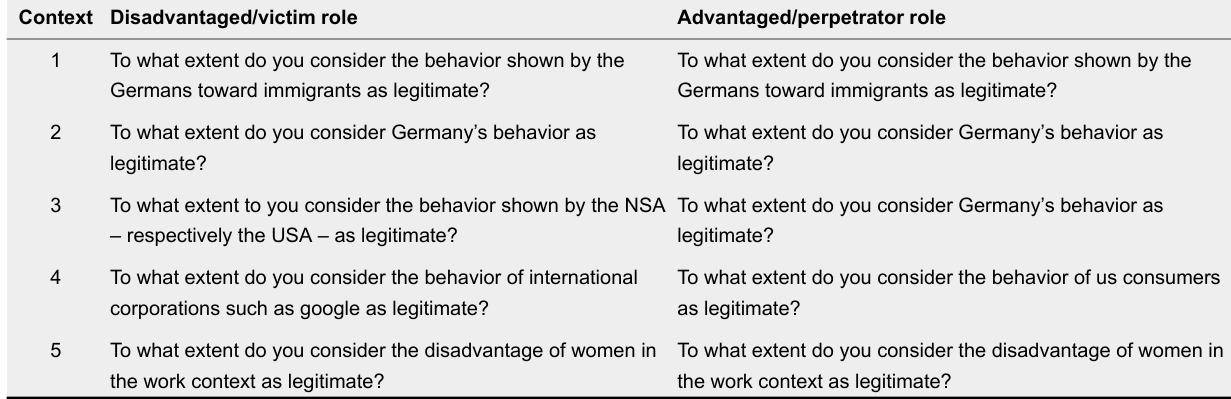
Legitimacy Manipulation Checks Used in Study